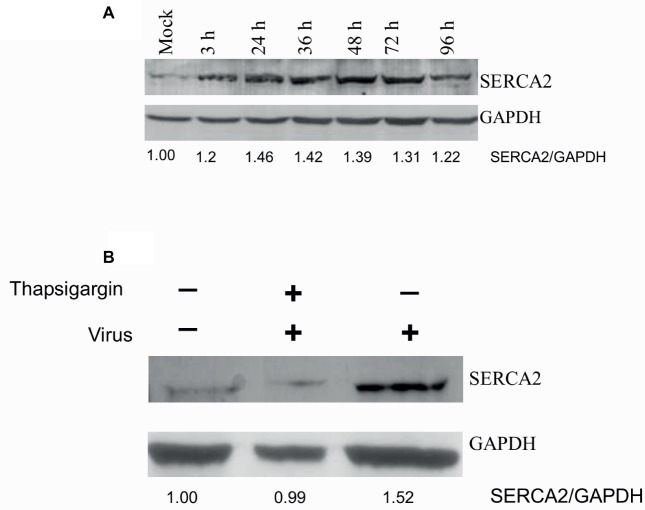
Paramyxovirus infections induce SERCA expression. (A)
PPRV infection induces SERCA2 expression: Vero cells were infected with PPRV at MOI 5, and the cell lysates were prepared at indicated time points. The levels of SERCA2 (upper panel) or house-keeping control protein (GAPDH) (lower panel) were examined by Western blot analysis. (B)
Thapsigargin inhibits NDV-induced SERCA2 expression in Vero cells: Vero cells were infected with NDV at MOI of 5 for 1 h followed by washing with PBS and addition of fresh medium containing Thapsigargin or vehicle control (0.05% DMSO). Cell lysates were prepared at 16 hpi to probe SERCA2 and GAPDH by Western blot analysis. Relative fold-change in the levels of viral/cellular proteins was determined by ImageJ (NIH).